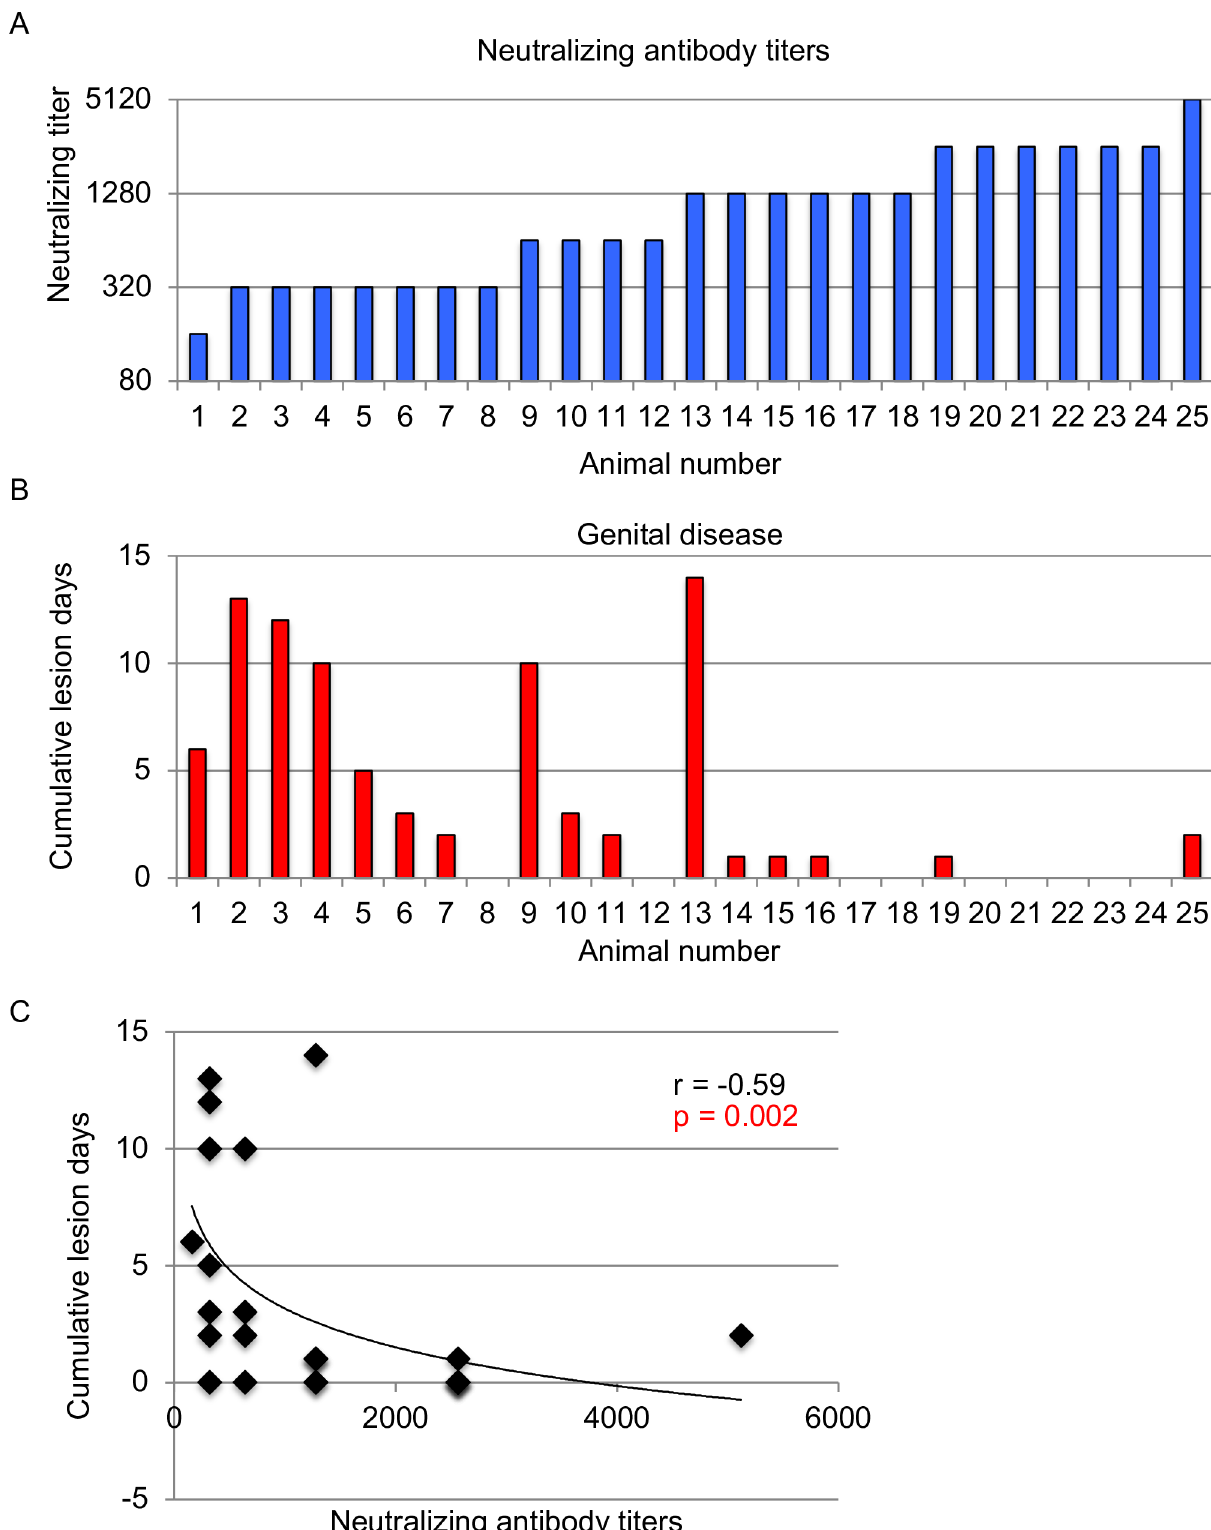
Fig 1. Neutralizing antibody responses correlate with protection against HSV-2 genital lesions. (A) Serum neutralizing antibody titers are plotted from guinea pigs immunized with gD2. Serum was obtained after the third immunization. Animals are ranked from lowest to highest neutralizing